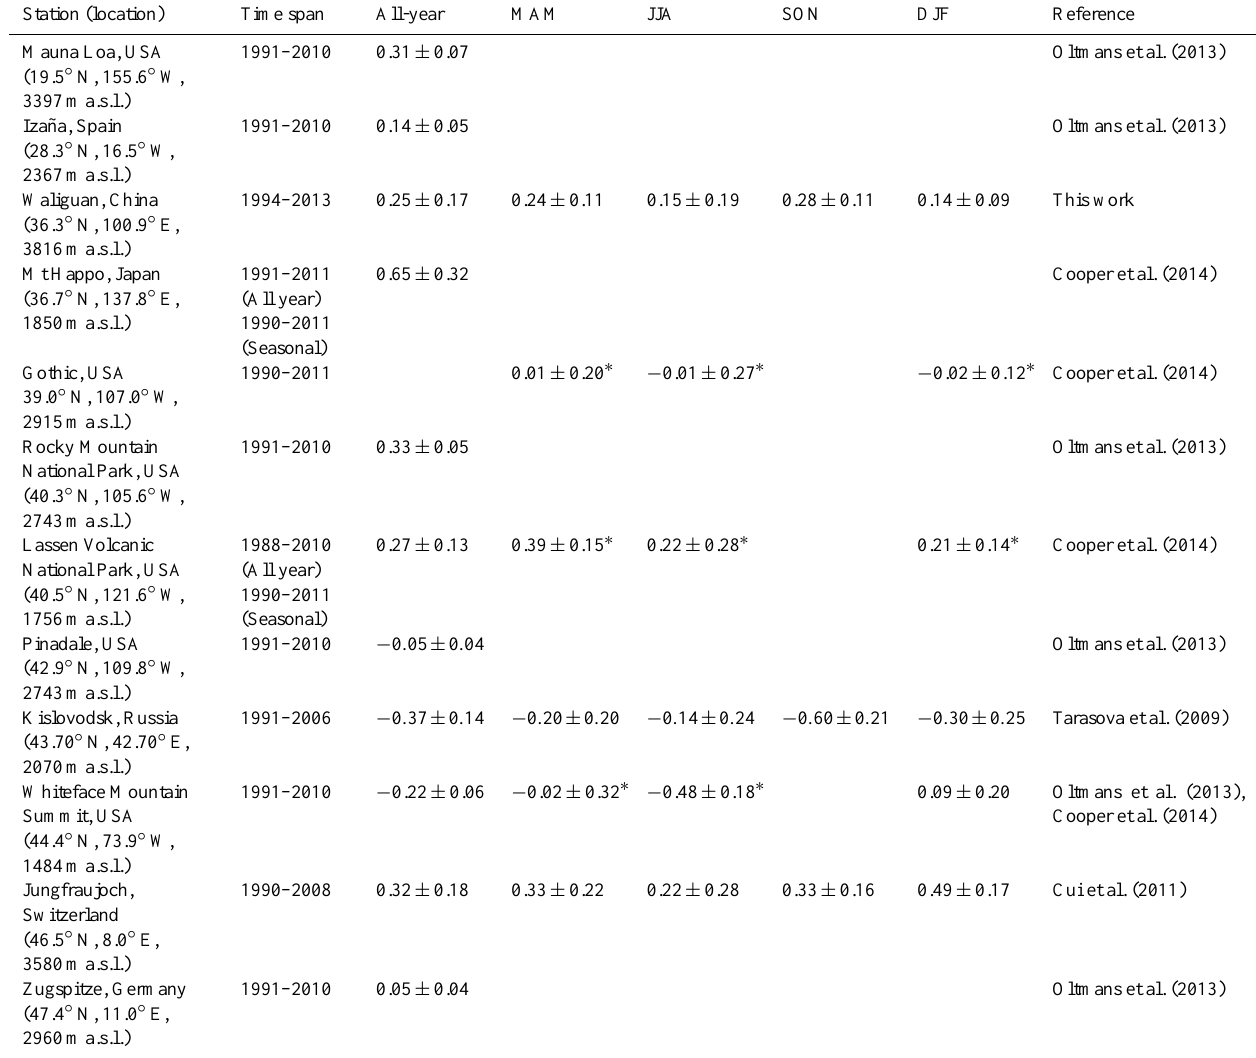
Table 2. The linear slopes (in ppbvyear − 1 ) and the 95% confidence intervals of all-year and seasonal average surface ozone mixing ratio at WLG and other North Hemispheric high-altitude